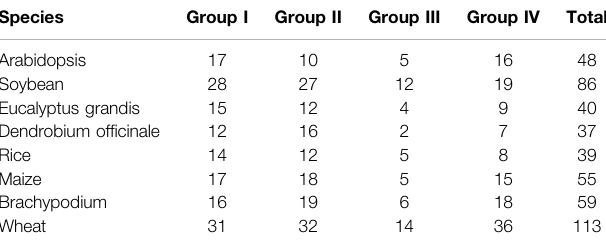
TABLE 2 | Comparison of the number of HD-Zip genes in D. of fi cinale wheat with seven other